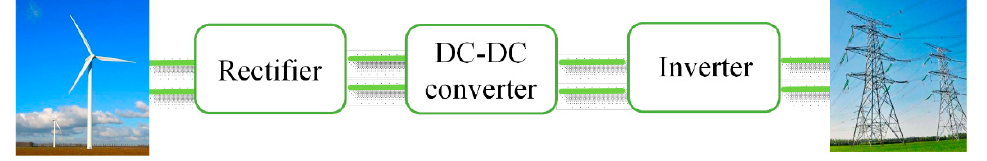
Figure 1. The topology of the traditional three-stage grid-connected small-scale wind generation Figure systems.